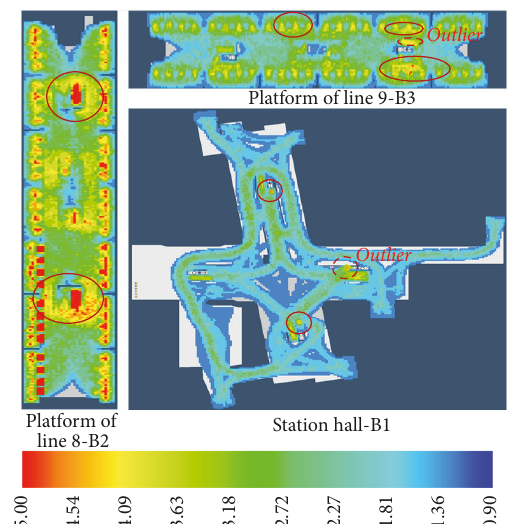
Figure 8: The cascading failure in network 𝑁 2 .